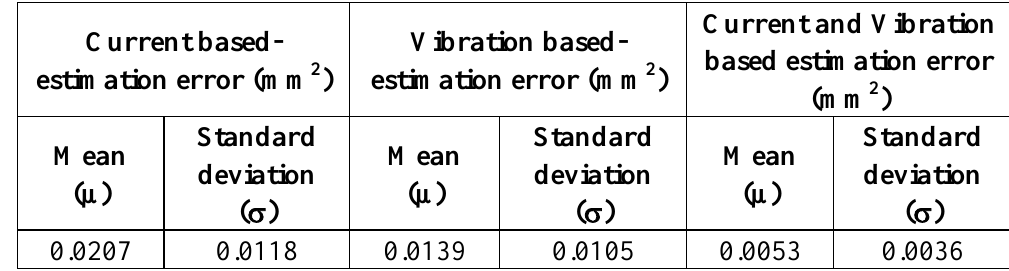
Table 2. Absolute errors of single- and fused-parameter